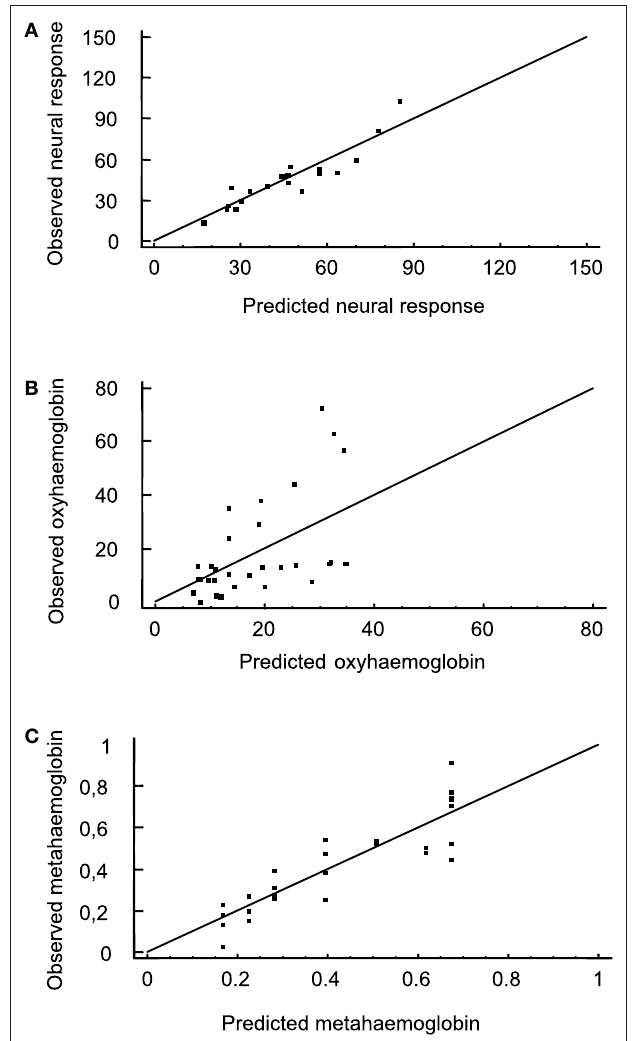
FIGURE 4 | Predictions obtained from the model (II). Multiple polynomial regression models were applied again for the mean values over the sampled neurons of each animal. Predicted-observed plot for neuronal responses (A) , OxyHb (B) and MetHb (C) . The horizontal axis denotes the predicted values, while the vertical axis represents the observed values. The straight line is the diagonal accounting for perfect